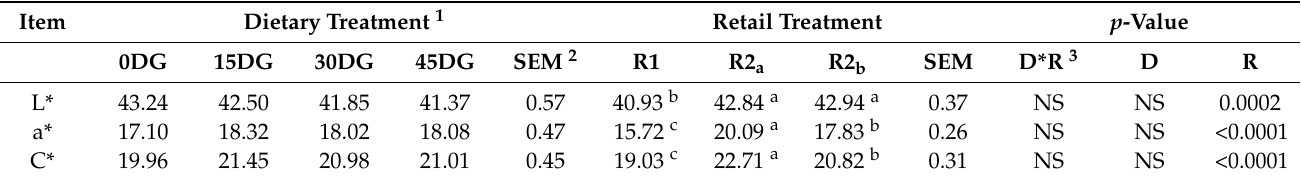
Table 5. Color parameters (CIELab) in LTL muscle at the end of each storage and retail display